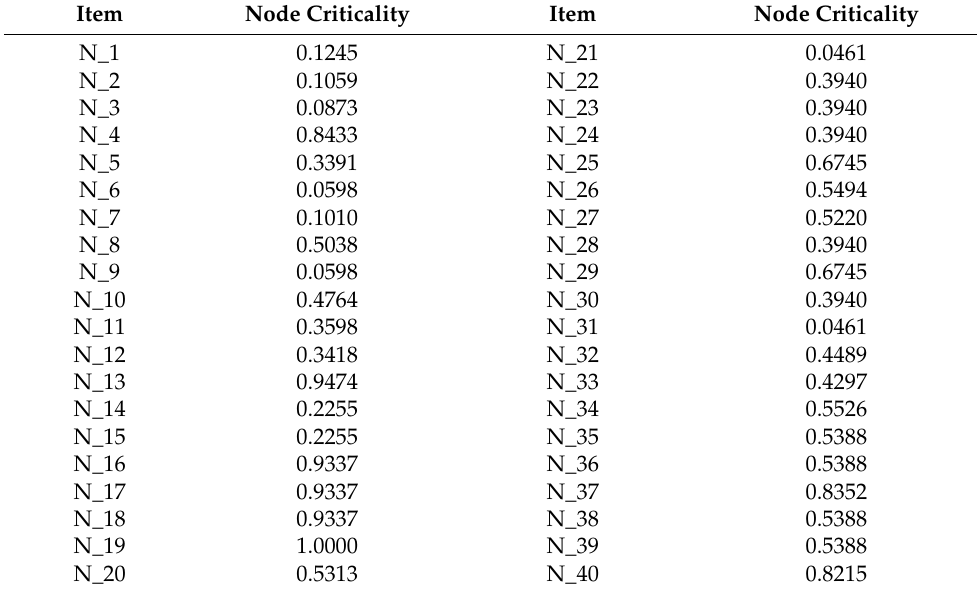
Table 4. Criticality values for nodes.